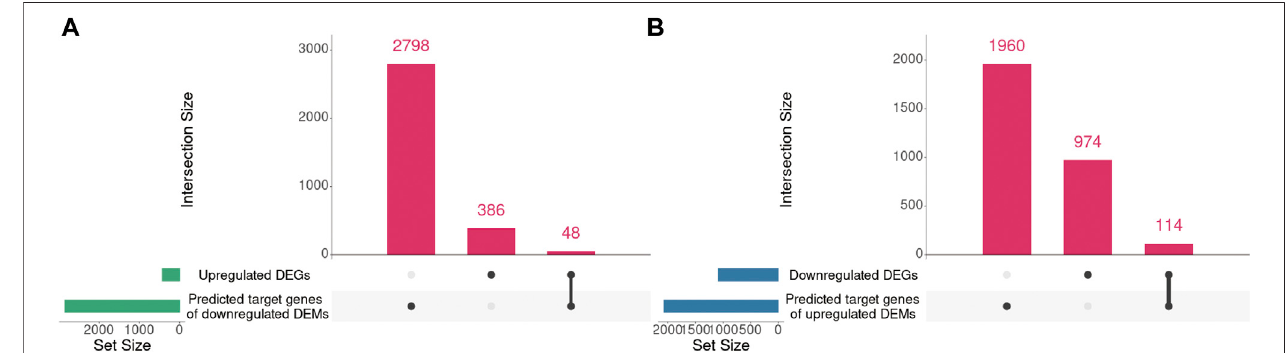
FIGURE4| TheintersectionofDEGsandpredictedtargetgenesofDEMs. (A) .TheintersectionofupregulatedDEGsandpredictedtargetgenesofdownregulated DEMs. (B) .TheintersectionofdownregulatedDEGsandpredictedtargetgenesofupregulatedDEMs.UpSetplotoftheintersectionofDEGsandpredictedtargetgenes ofDEMs.Thetransversebargraphatthebottomleftshowsthenumberofgenesenrichedineachpathway.Theblackdotsatthebottomleftandthebargraphatthetop indicate genes. The bars above represent the number of genes corresponding to each intersection.